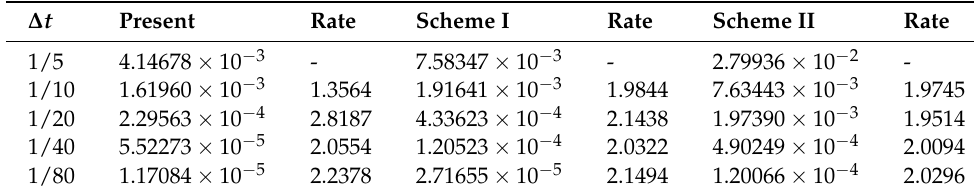
Table 2. Error comparison and temporal convergence orders in (cid:107) · (cid:107) ∞ -norm using h = 0.0005 and T =